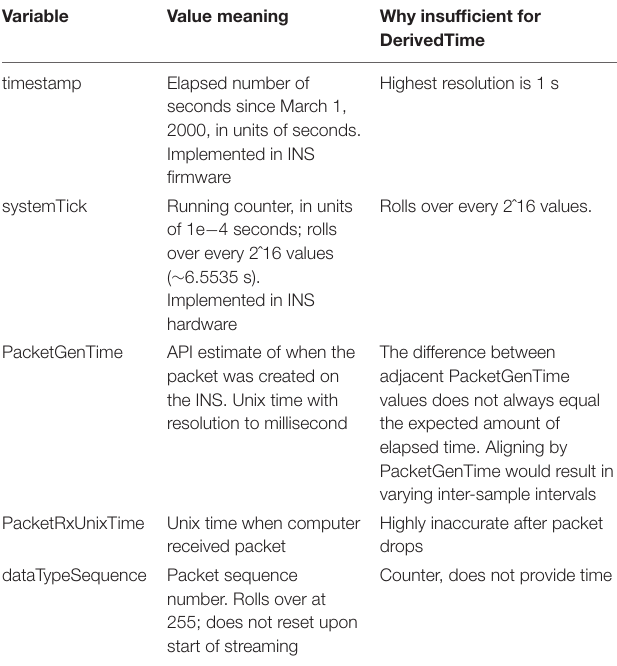
TABLE 4 | Time and count variables associated with each packet of data from the RC + S